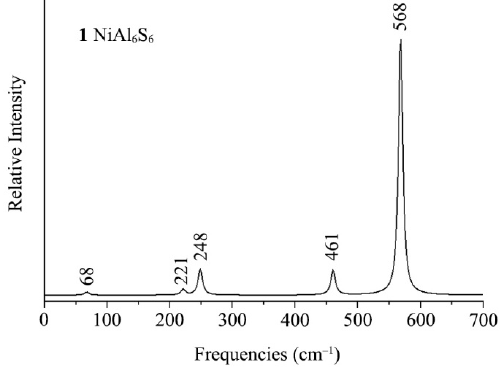
Figure 8. Calculated IR spectrum of NiAl 6 S 6 at the PBE0/def2-TZVP level.